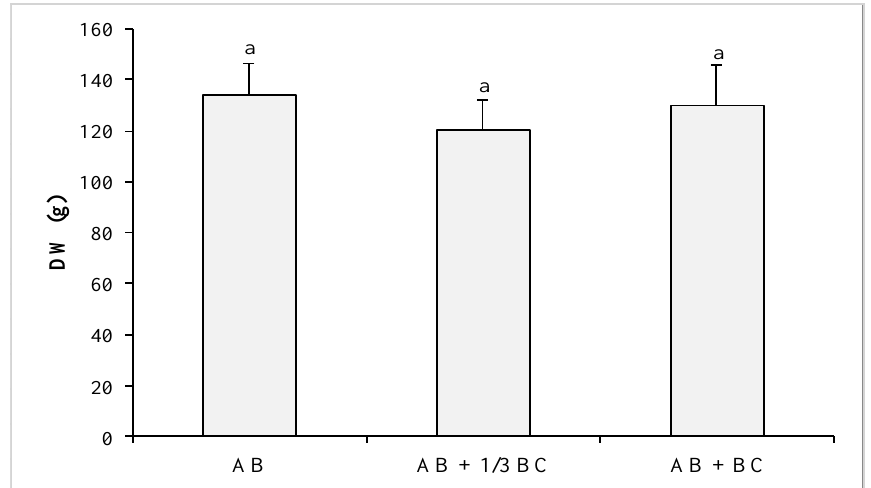
Figure 4. Stems dry weight (DW = g) of the Alnus planted in March 2019 (T0) and sampled in October 2020 (T19), grown on Abbaretz (AB) technosol non amended or amended with 2% biochar added on the top 33 cm of the tube (AB + 1/3 BC) or on all the tube (AB + BC). The treatment effect represented by the letters ( p ≤ 0.05) is mean of seven values (± SE).